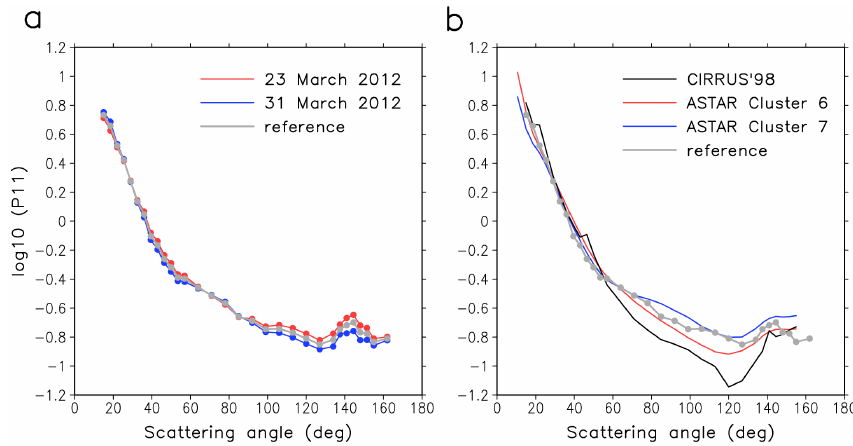
Figure 1. (a) Phase function of blowing snow as derived from the CLIMSLIP data on 23 March 2012 (red) and on 31 March 2012 (blue). The reference phase function P ref (grey) was defined as the average of the 23 and 31 March cases. (b) Comparison of P ref 11 for non-precipitating cirrus (CIRRUS’98, black line) and glaciated Arctic nimbostratus (ASTAR clusters 6 and 7, red and blue